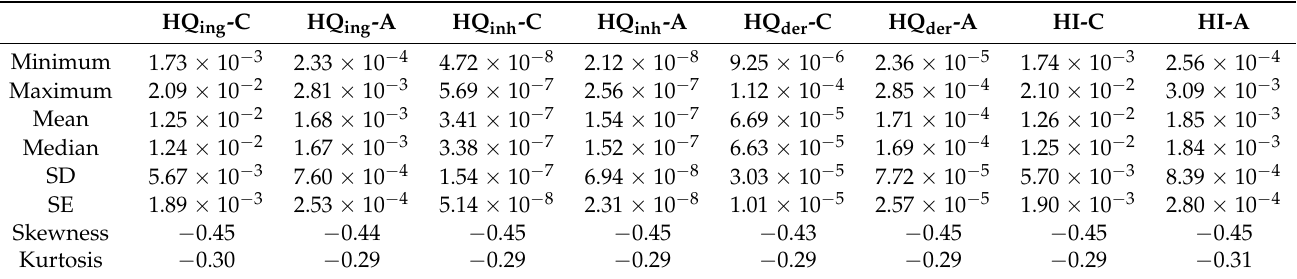
Table 5. Overall values of hazard quotient (HQ), and hazard index (HI), in the three exposure routes of Cu for children (C) and adults (A) in in Klang River estuary and a site in Juru estuary. N= 9. HQ ing